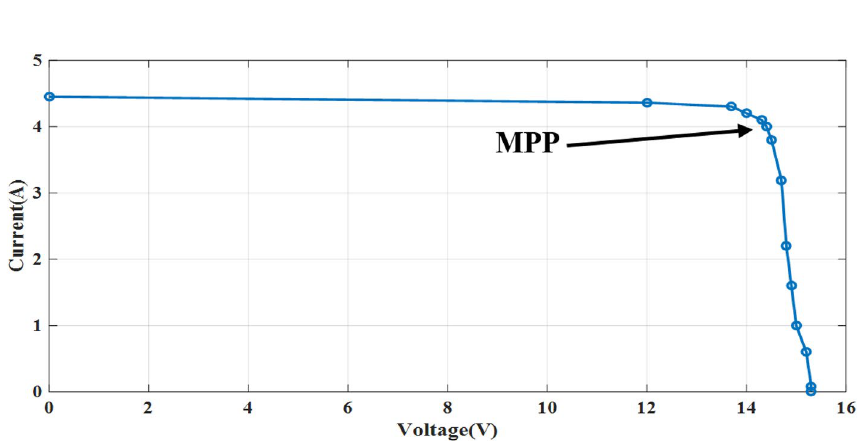
Figure 20. Experimental I – V graph of the NST PV